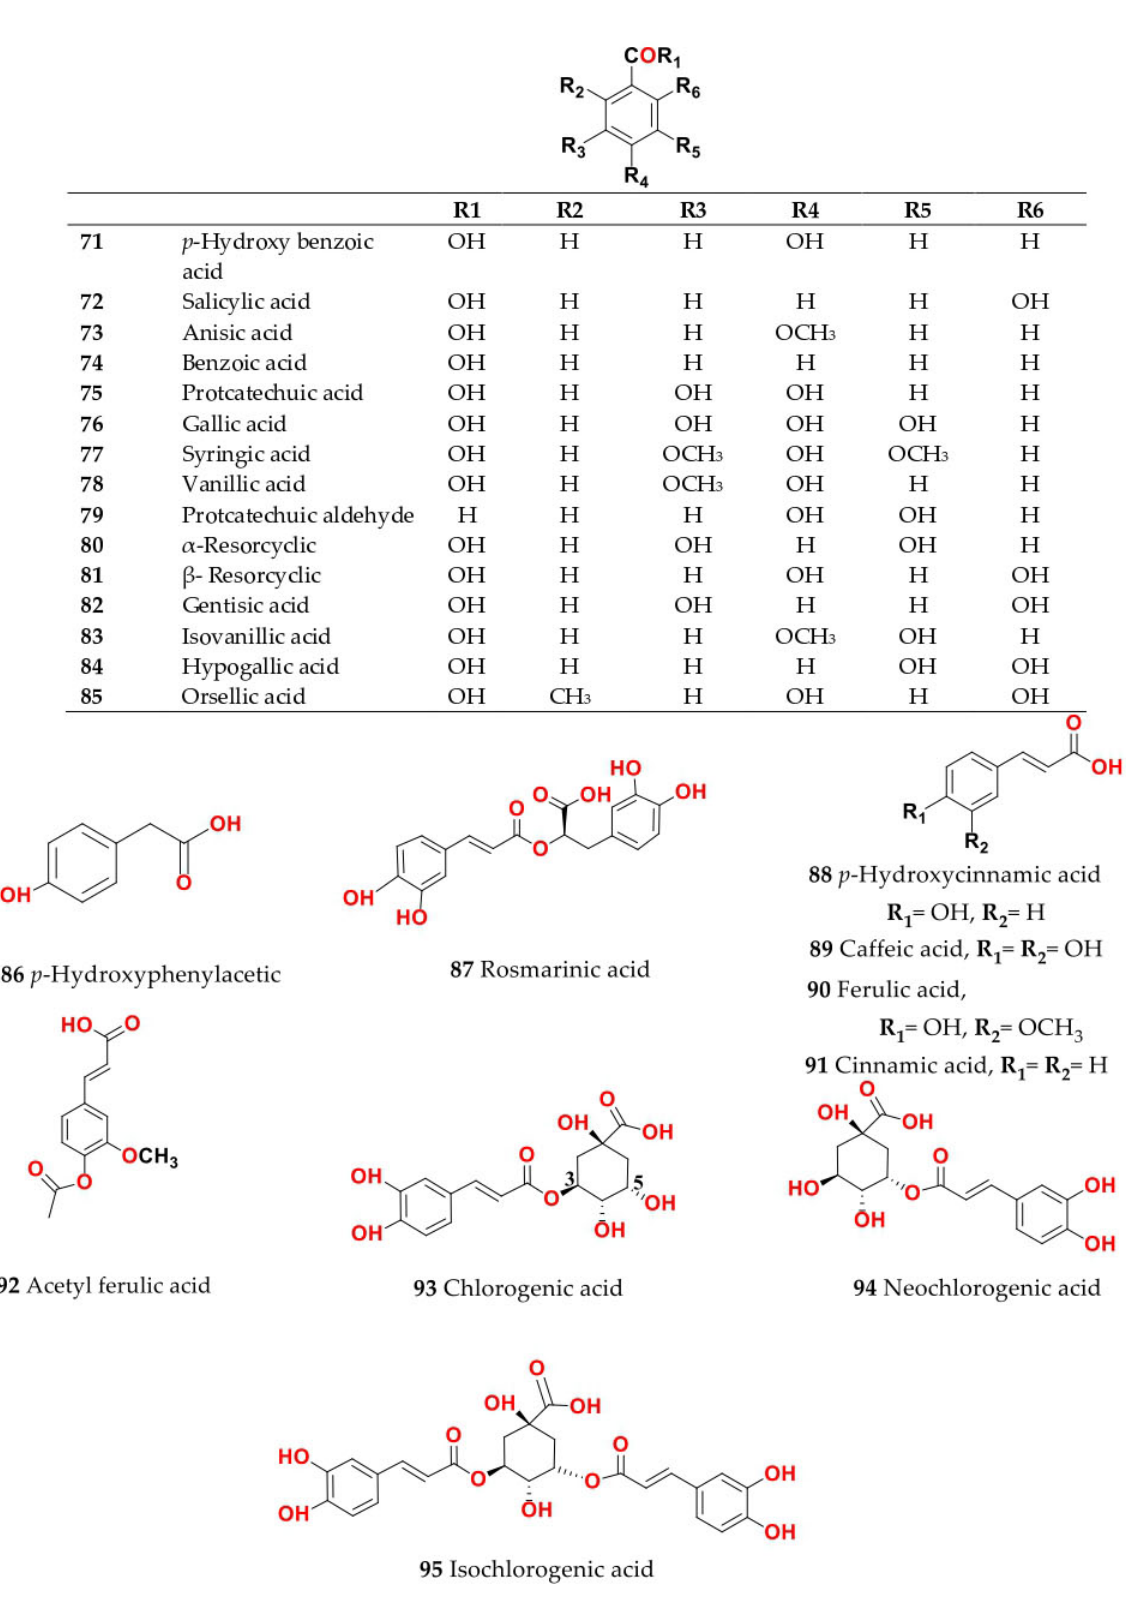
Figure 7. Chemical structure phenolic acids isolated from genus Salsola.